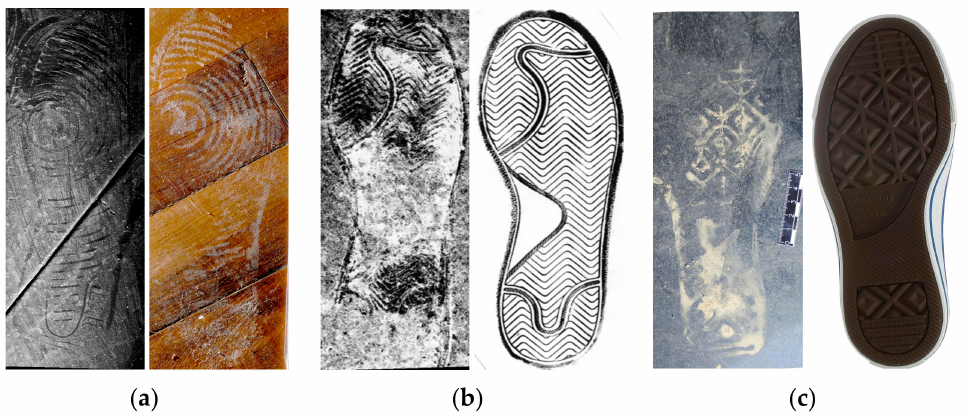
Figure 1. Differences among the three kinds of shoeprint retrieval tasks: ( a ) S2S shoeprint retrieval. ( b ) S2R shoeprint retrieval. ( c ) S2P shoeprint